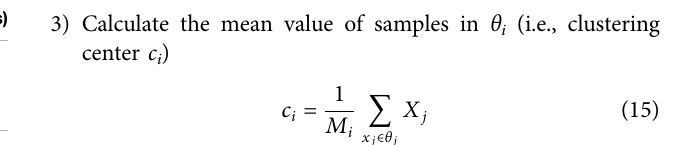
TABLE 6 | Prediction error of different RBF spread.